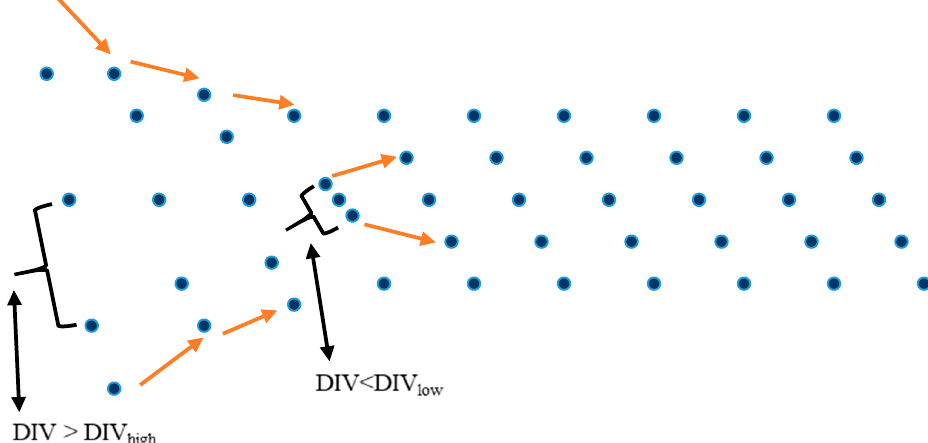
Figure 1. Particle movement in diversity-enhanced particle swarm optimization (DEPSO).